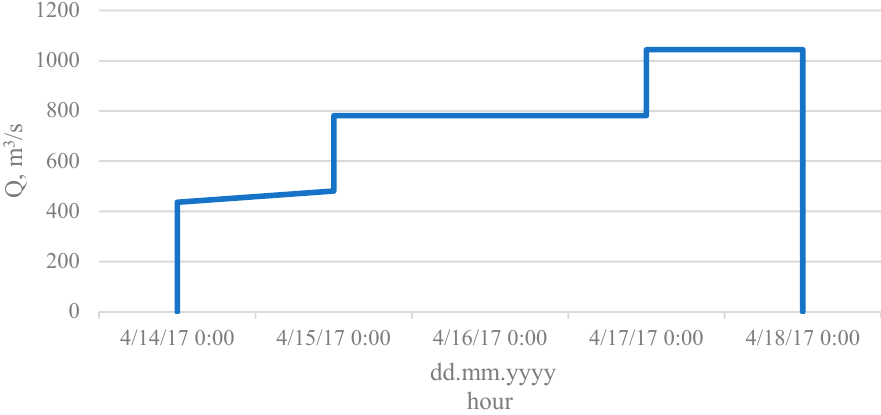
Figure 3. Hydrograph of water release from the Astana Reservoir during spring snowmelt in April 2017.